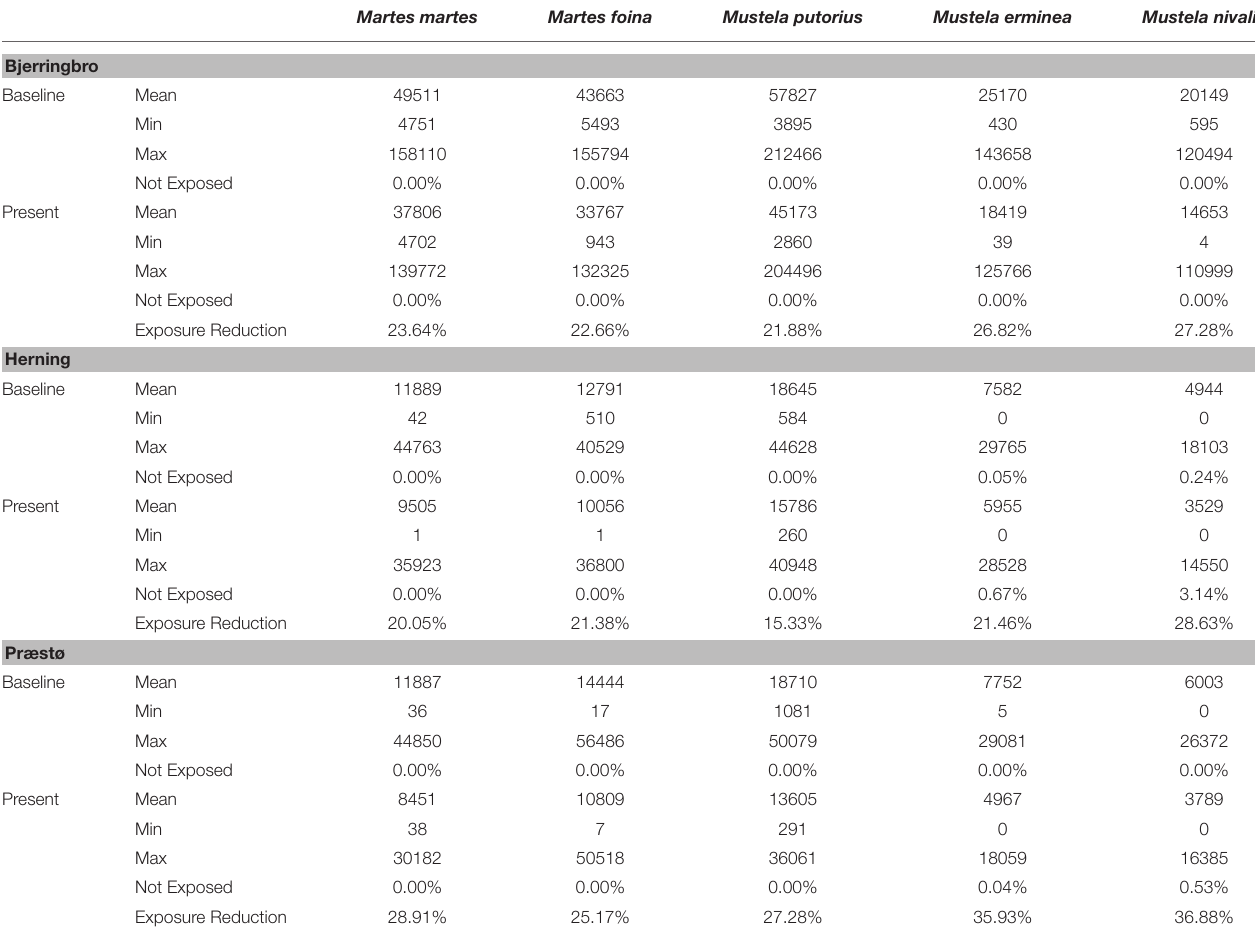
TABLE 5 | Results of Experiment 1 for the each of the three landscapes as exposure indices. Martes martes Martes foina Mustela putorius Mustela erminea Mustela